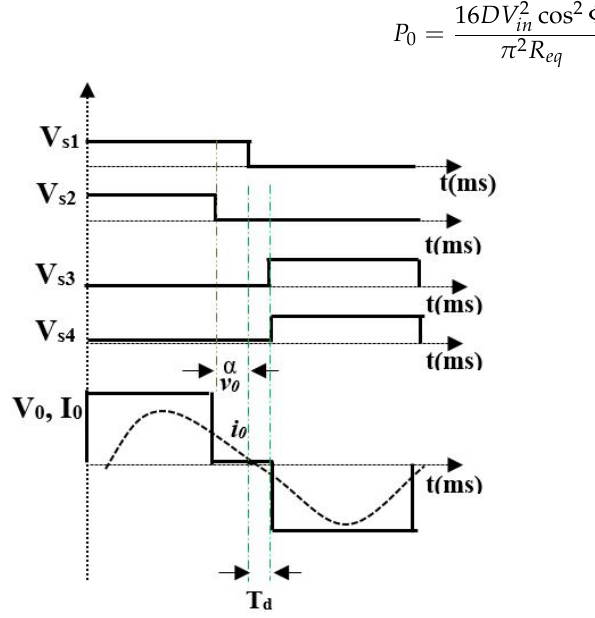
Figure 2. Typical waveforms of duty cycle